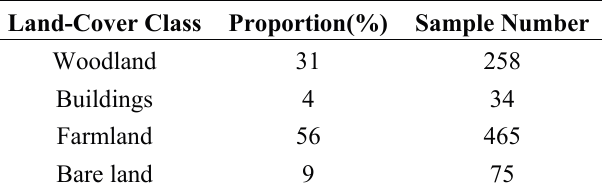
Table 4. The sample